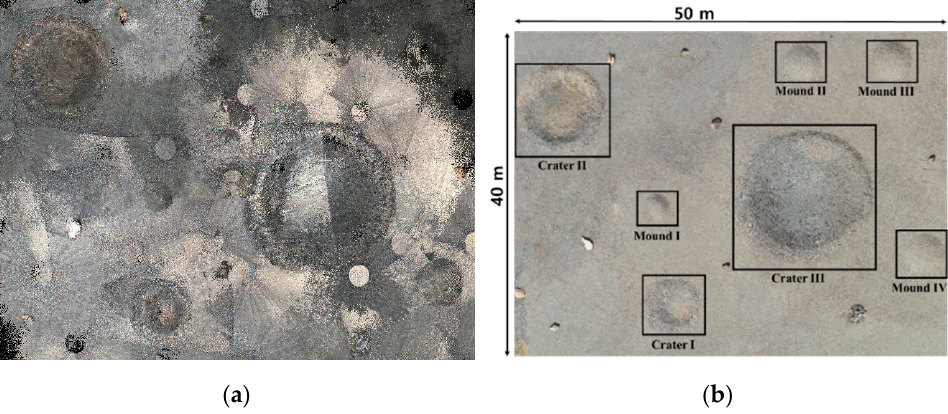
Figure 8. The 3D point-cloud mapping results and terrain features in the test site: ( a ) 3D dense point-cloud; ( b ) terrain features.